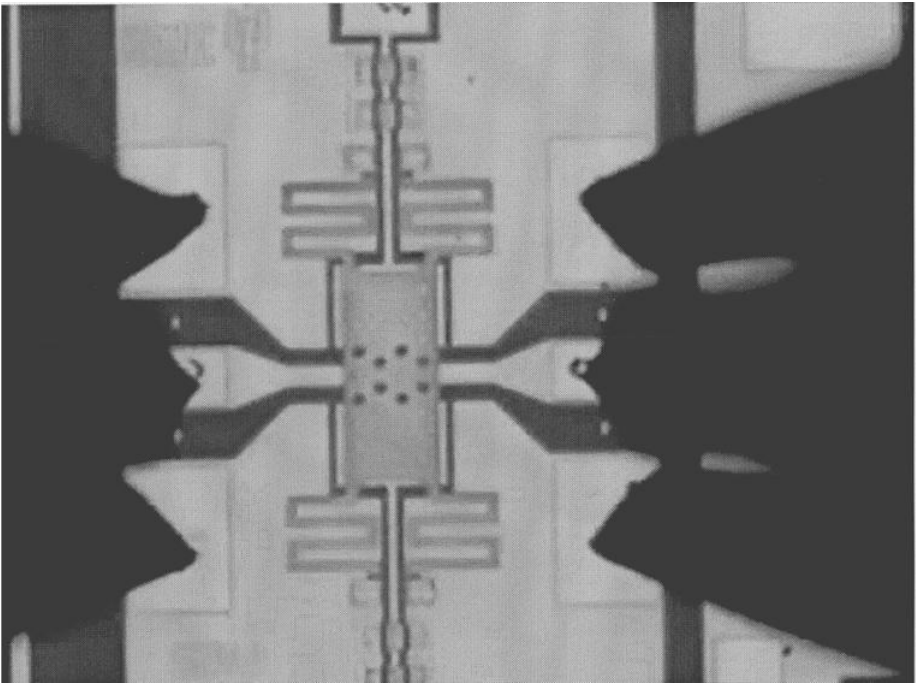
FIGURE 5 A microscope picture of a fabricated cantilever